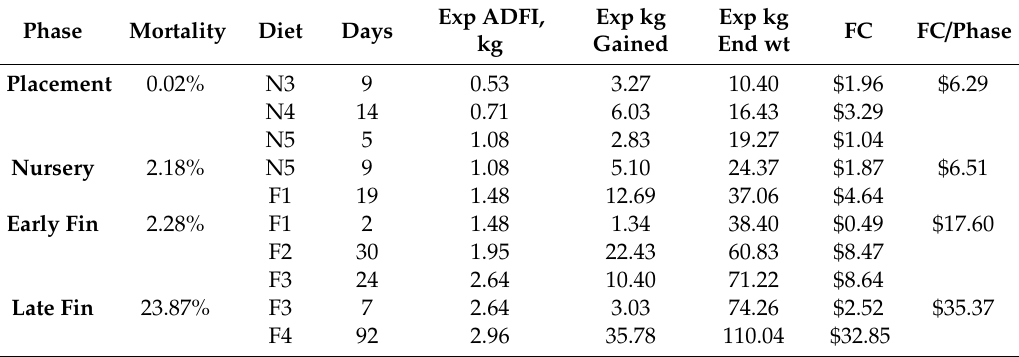
Table 6. Cluster I feed and gain calculation after ADG factor adjustments. The result of increased days on diet F4 and ADG adjustments (Table 4) on feed costs and late finishing phase ending weight. Thus accounting for average days on feed and average market weight for cluster I, as reported by the farm.